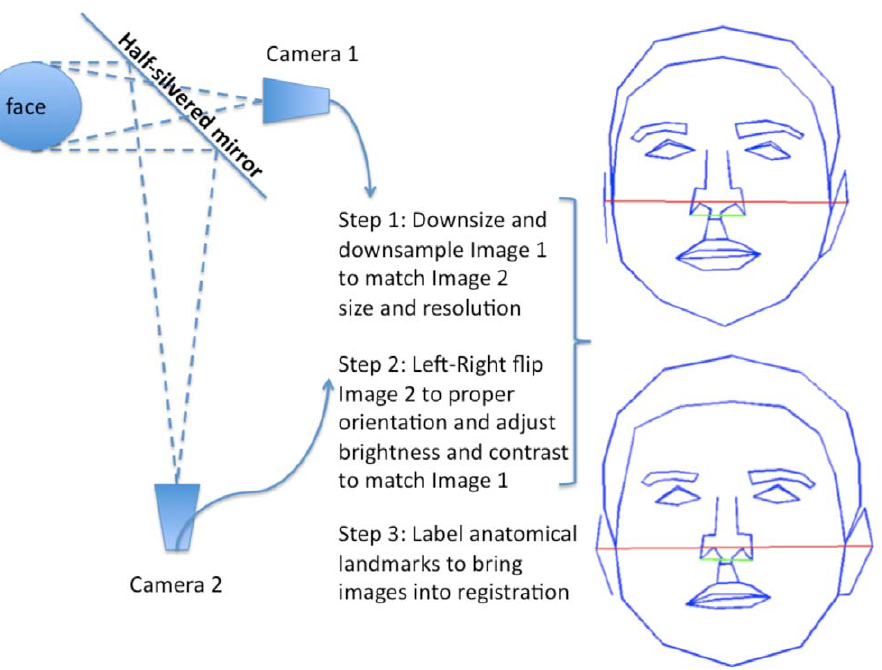
Figure 4. Creation of stimuli. The schematic illustrates how the two photographs of a face were taken at two distances simultaneously, and summarizes the post-processing steps to equate the resultant images and generate the stimuli.